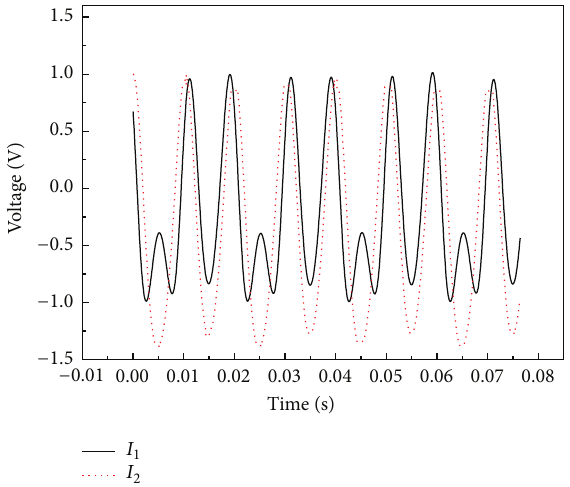
Figure 5: Two sinusoidal signals induced from a dual-cavity fiber Fabry-Perot